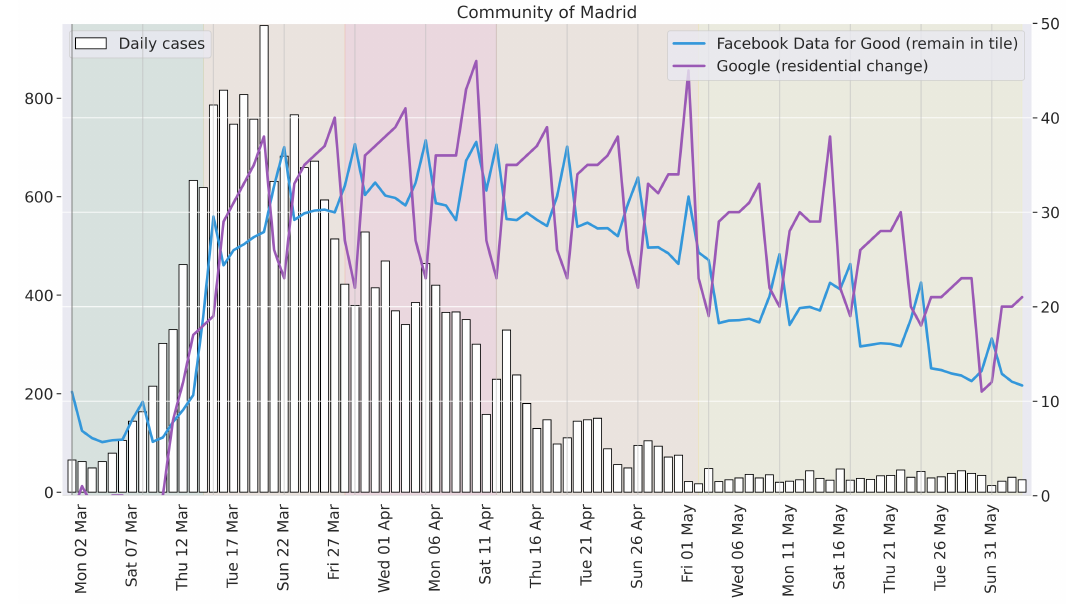
Figure 3. Mobility containment in Madrid according to Facebook’s remain in tile and Google’s residential index, together with the number of reported cases daily in Madrid [36] shifted two weeks early to approximate contagion